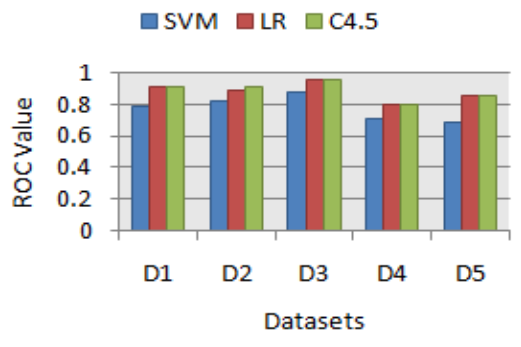
Figure 3. Prediction results of machine learning techniques in terms of ROC value for different datasets based on temporal and spatial contexts.